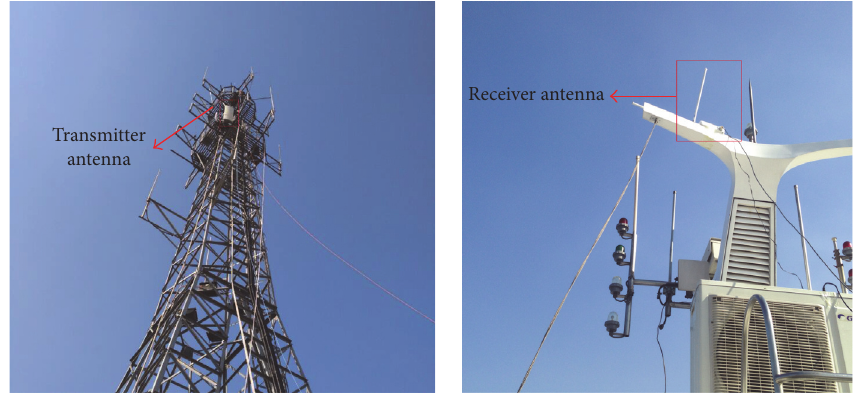
Figure 4: Transmitter antenna and receiver